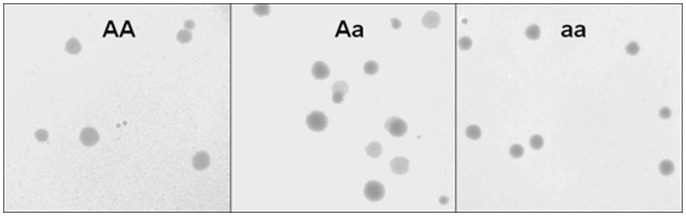
Plaque genotyping assay.Progeny from a single coinfected cell were plated on a mixed lawn of the standard (P. phaseolicola) and novel (P. glycinea) hosts. Mutant (a) progeny can infect both hosts and result in clear plaques, while wildtype (A) progeny only infect the standard host and result in turbid plaques. The coinfection type can be identified as either AA (only turbid plaques; left panel), Aa (both turbid and clear plaques; center panel) or aa (only clear plaques; right panel).